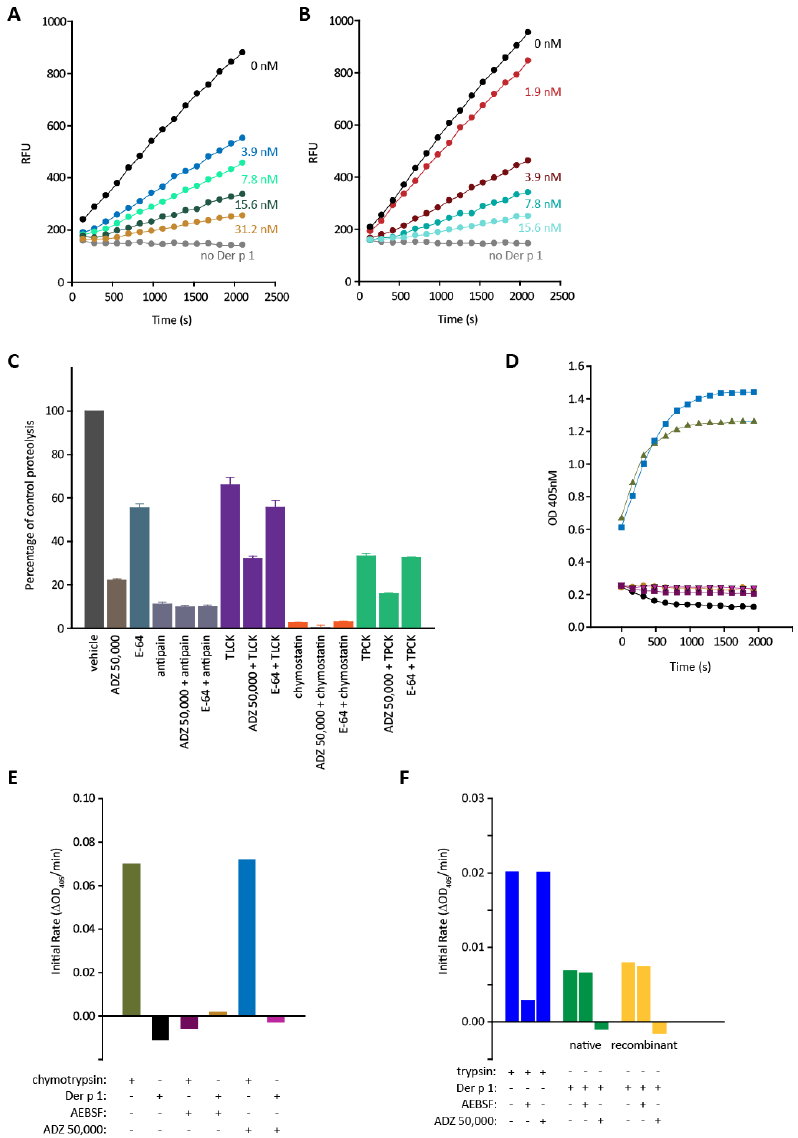
Figure 1. Proteolysis of ADZ 50,059 by Der p 1 or mixed HDM allergens and its inhibition. ( A ) Progress curves for cleavage by Der p 1 in the absence or presence of a range of concentrations of ADZ 50,000. ( B ) Inhibition of Der p 1 by Compound 4 . In both ( A ) and ( B ), the grey lines show data in the absence of added enzyme. Progress curves are depicted as a single data set which was replicated twice on a single 96-well plate and >3 times for each compound on separate occasions. ( C ) Proteolysis of ADZ 50,059 by mixed HDM allergens containing 40 nM Der p 1 and the effects of inhibitors tested at the following concentrations: ADZ 50,000 (50 µM); E-64 (200 µM); antipain (200 µM); TLCK (1 mM); chymostatin (50 µM); TPCK (50 µM). Data are mean ± s.e. (n = 4). ( D ) Example progress curves for the cleavage of N -succinyl-Ala-Ala-Pro-Phe- p -nitroanilide by chymotrypsin (green triangles) and its modification by 400 µM AEBSF (purple squares) or 40 µM ADZ 50,000 (blue squares). Corresponding data are presented for native Der p 1 (black circles) with AEBSF (orange circles) or ADZ 50,000 (magenta triangles) showing that this substrate is insensitive to pure Der p 1. ( E ) Example initial rates of reaction as determined from an experiment similar to that depicted in ( D ) confirming the resistance to degradation of the chymotrypsin substrate and the lack of inhibitory activity of ADZ 50,000 on chymotrypsin. ( F ) Processing of N -Bz-Phe-Val-Arg- p -nitroanilide by trypsin (blue), native Der p 1 (green), and recombinant Der p 1 (yellow) and the effects of 80 µ M AEBSF or 8 µ M ADZ